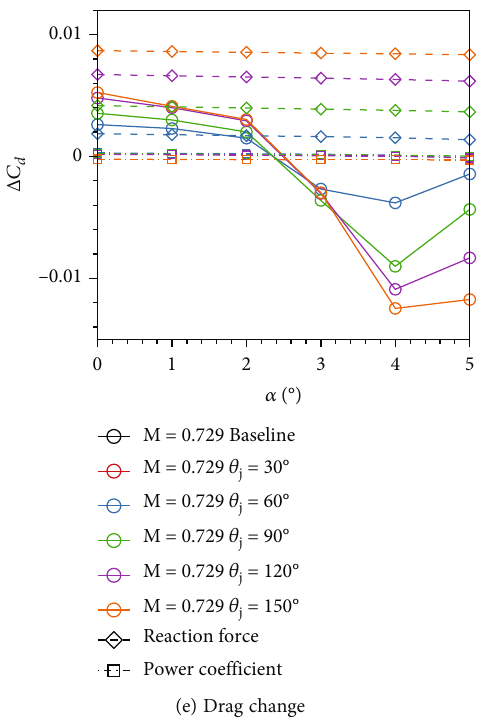
= 0 : 729 and C = 0 : 005 ∞ μ